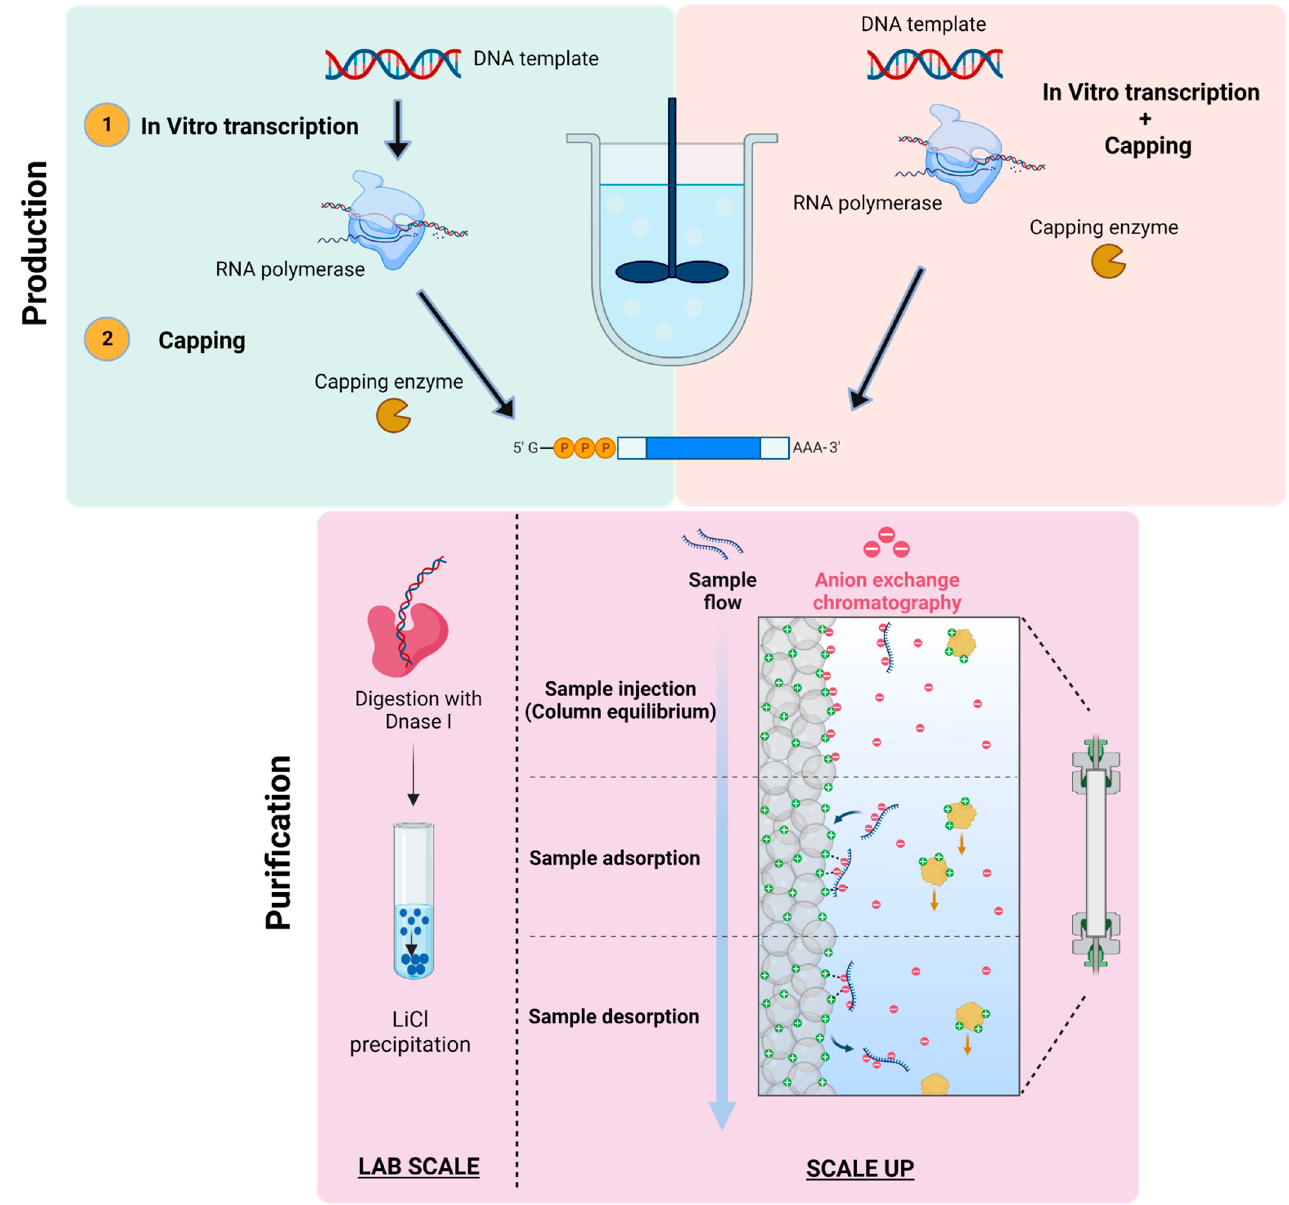
Figure 6. Manufacturing process of mRNA sequence. (Created with BioRender.com accessed on 1 January 2023).